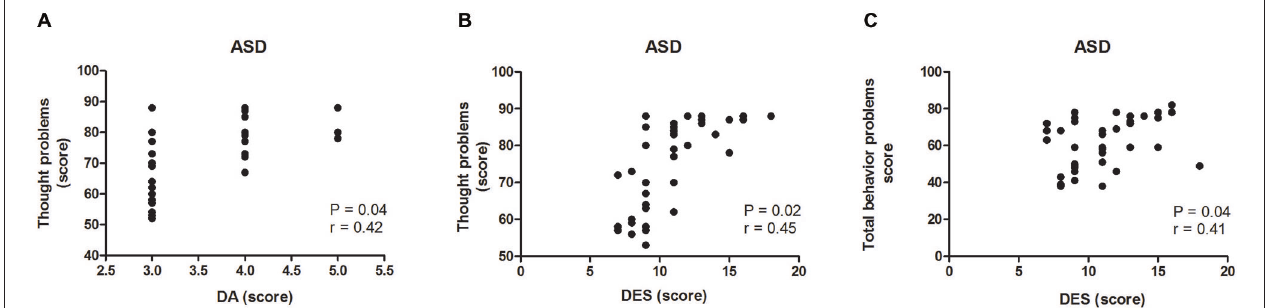
disorders of excessive somnolence—DES—and thought problems in the ASD group ( p < 0.05; r = 0.45); In (C) correlation between disorders of excessive somnolence—DES—and behavioral problems in the ASD group ( p < 0.05; r =